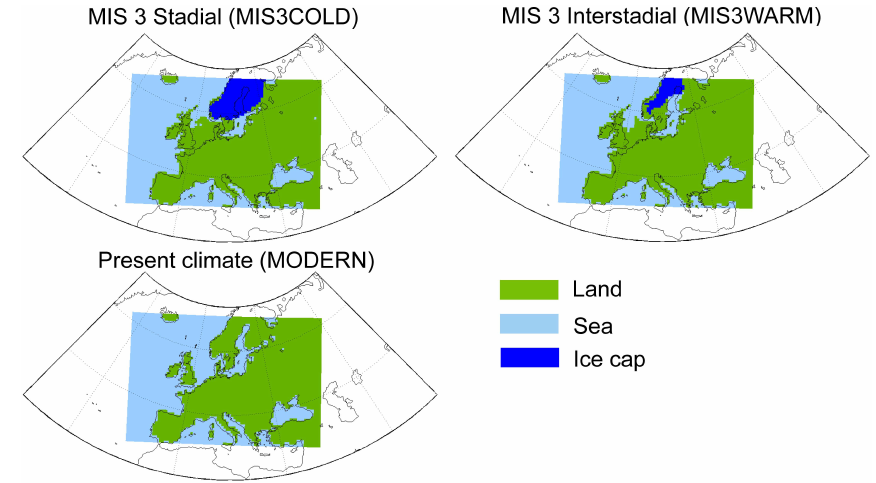
Fig. 1. Land, sea and glacial ice distribution for the MIS3 stadial (MIS3COLD), interstadial (MIS3WARM) and present-day control (MOD- ERN) climate model experiments of the Stage 3 project (see Barron and Pollard, 2002 for a more extensive description of the STAGE3 climate model